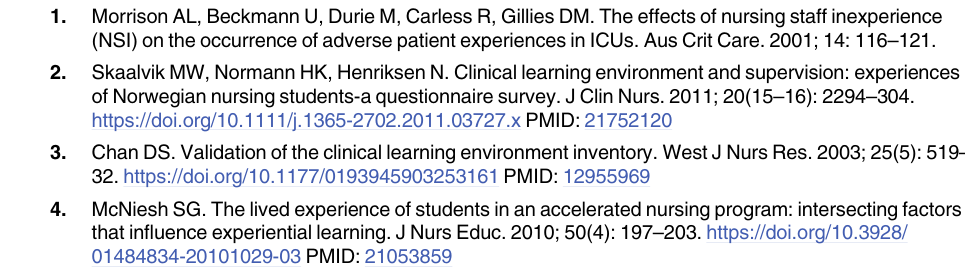
S1 Table. DATA1 introduction ~ patient care. This is the value of the parameter at simula- tion phases from introduction to patient care. S2 Table. DATA2 reporting ~ debriefing. This is the value of the parameter at simulation phases from reporting to